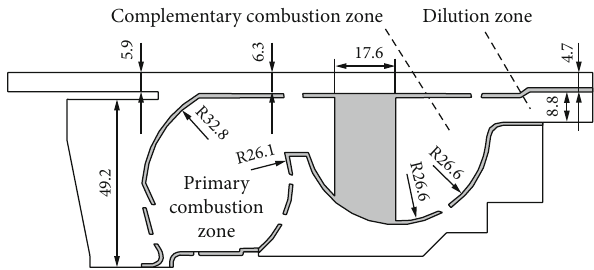
Figure 1: Schematic view for the structure of the combustor.